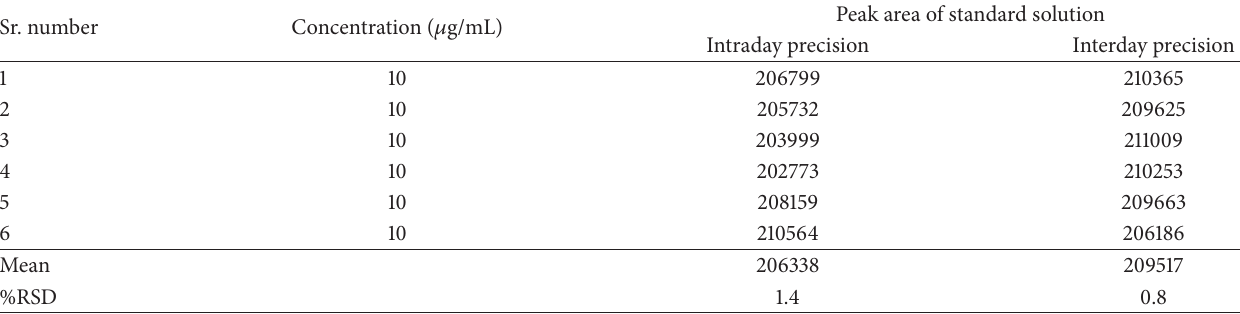
Table 4: Intraday and interday precision of the method.